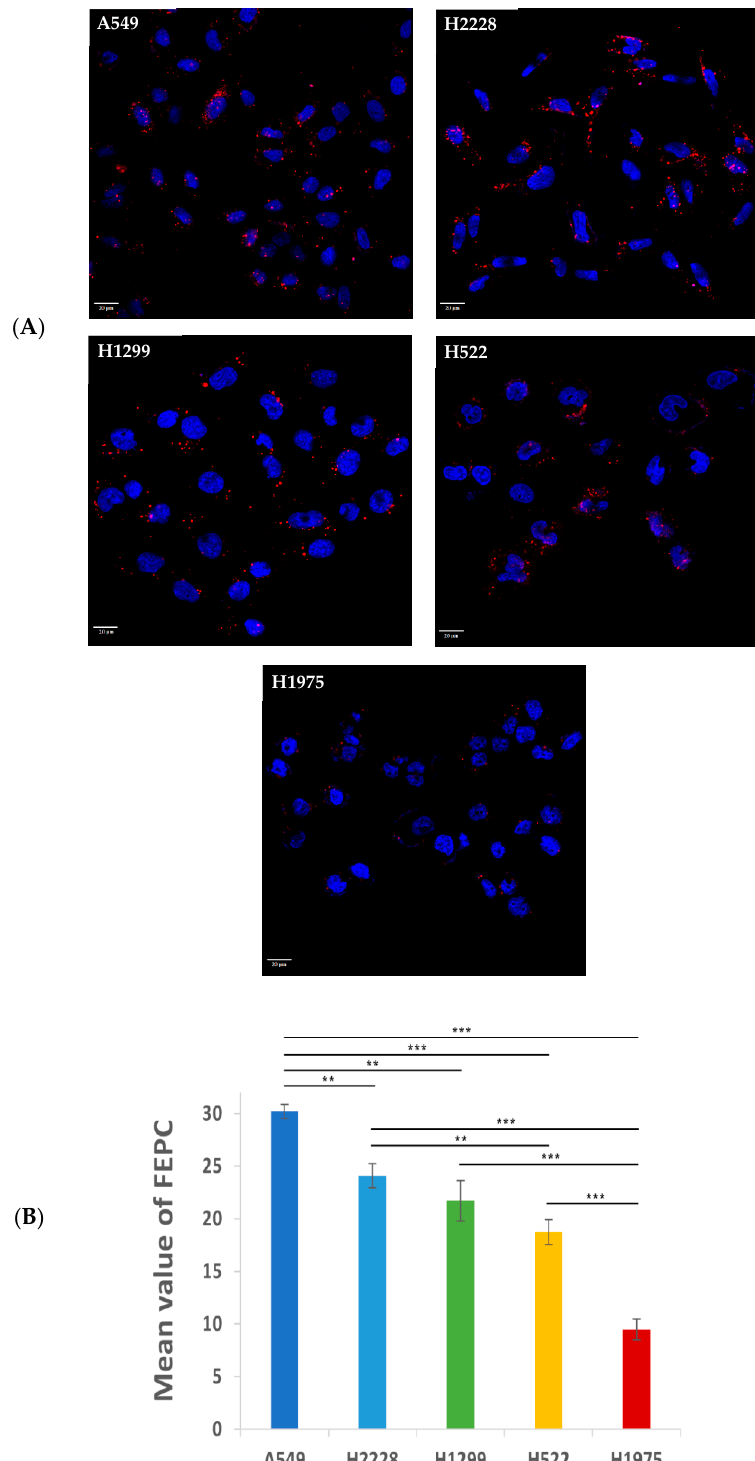
Figure 3. ( A ) Variable internalization of APT-NPs by various NSCLC cells at 37 ◦ C. Confocal laser microscopy images of NSCLC subtypes exposed to PEG-PCL NPs decorated with S15 APTs. The tumor cell lines were H2228, H1299, H522 and H1975. Cells were incubated at 37 ◦ C, for 2 h, in FBS-free medium, containing APT-NPs labeled with Cy7 (red). Nuclear DNA was labeled with Hoechst 33342 (2 µ g/mL) (blue). A 20 µ m scale bar is shown. ( B ) Mean FEPC values ± SE of Cy7-labeled S15 APT-NPs. Values were determined using IMARIS software in the images shown in ( A ). ** p < 0.01, *** p < 0.001, unpaired, two-tailed t